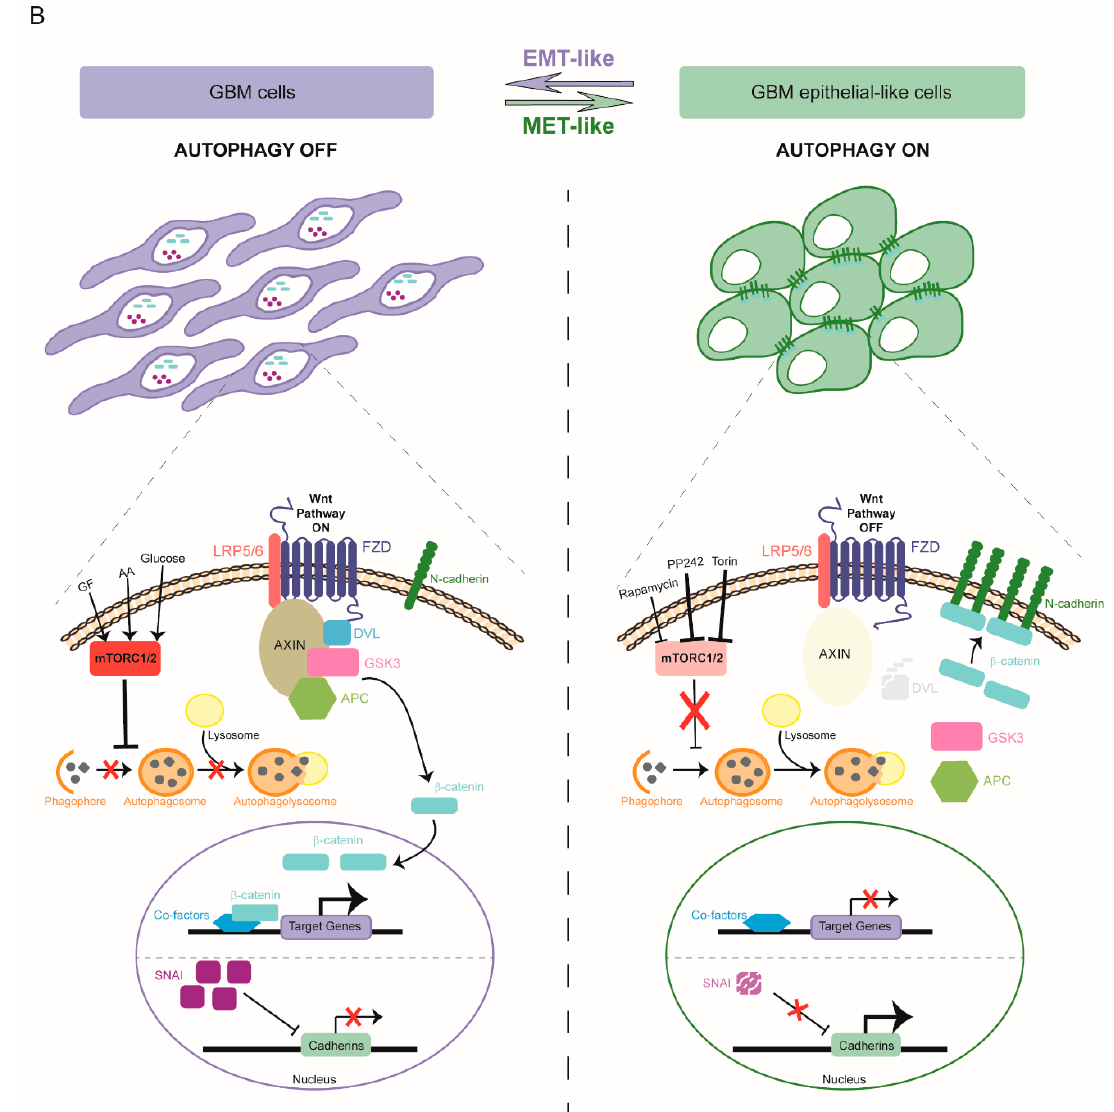
Figure 1. Effects of autophagy modulation on GBM migration/invasion capabilities from opposite point of views. ( A ) Autophagy induction promotes GBM cells invasiveness and viceversa. Upon different stimuli, autophagy is activated and a more invasive phenotype is observed in some models of GBM cells (right). Conversely, when autophagy is impaired by genetic knockdown of some autophagy-related genes, a less invasive phenotype is obtained (left). TGF β , Tumor necrosis factor β ; TMZ, Temozolomide. ( B ) Autophagy modulation promotes EMT/MET-like shifts in GBM cells. In nutrient-rich conditions, hyperactivation of the mTORC1/2 complexes impairs autophagy and Wnt pathway is active thus allowing β -catenin translocation to the nucleus where it promotes the transcription of pro-invasive molecules. In this condition, EMT players of the SNAI family express and repress cadherins expression. The genetic knockdown of autophagy related genes exacerbates the mesenchymal phenotype and enhances the cell migration capability. Upon autophagy induction, shown on the right, Dishvelled (DVL) is degraded and Wnt pathway inactivated leading to β -catenin accumulation into the cytosol. In autophagic cells, SNAI factors are down-regulated and, consequently, N-cadherin accumulates and binds β -catenin, thus promoting cell-cell